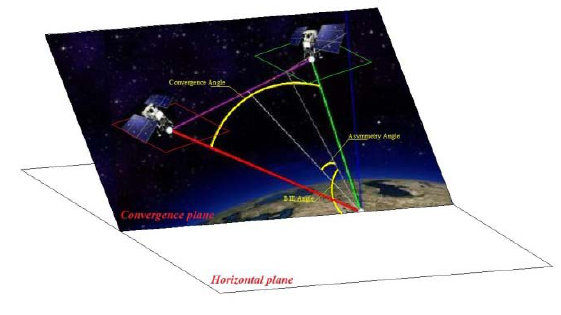
Figure 3. Stereo geometry angles